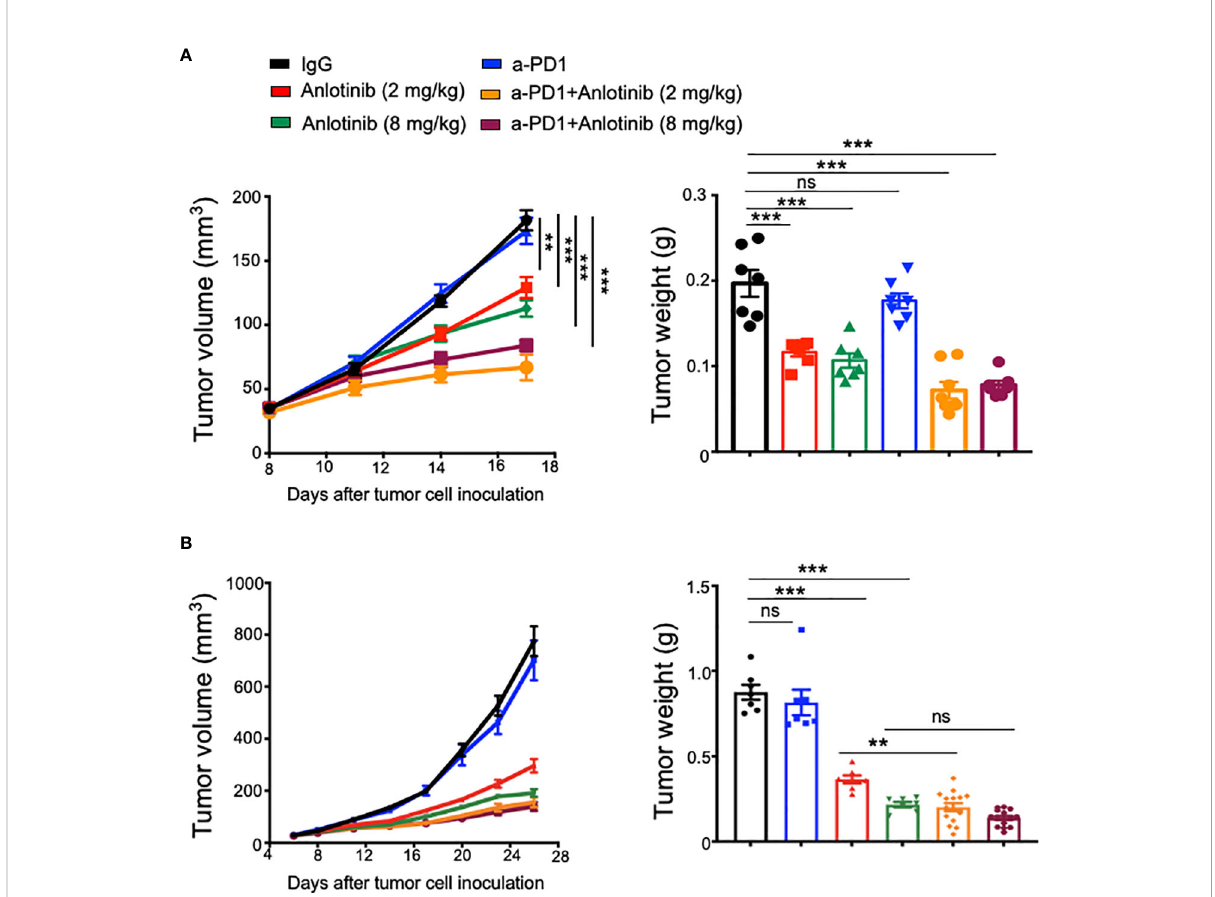
FIGURE 2 Effective low-dose Anlotinib improved anti-PD-1 therapy in both short- and long-term treatment regimens. EO771 tumor-bearing mice were prepared, and Anlotinib treatments (2 or 8 mg/kg/daily) were conducted as described in Figure 1. Treatments with anti-PD-1 or isotype IgG (5 mg/kg) were initiated when tumors reached 3 – 4 mm in diameter and continued every 3 days. Tumor growth curves and tumor weights with short-term (A) or long-term (B) combinations of Anlotinib and anti-PD-1 therapy are shown. The signi fi cance was determined by one-way ANOVA ( n = 7 – 15 mice per group). The data are presented as means±SEM. NS, no signi fi cant difference; ** p < 0.01; *** p <